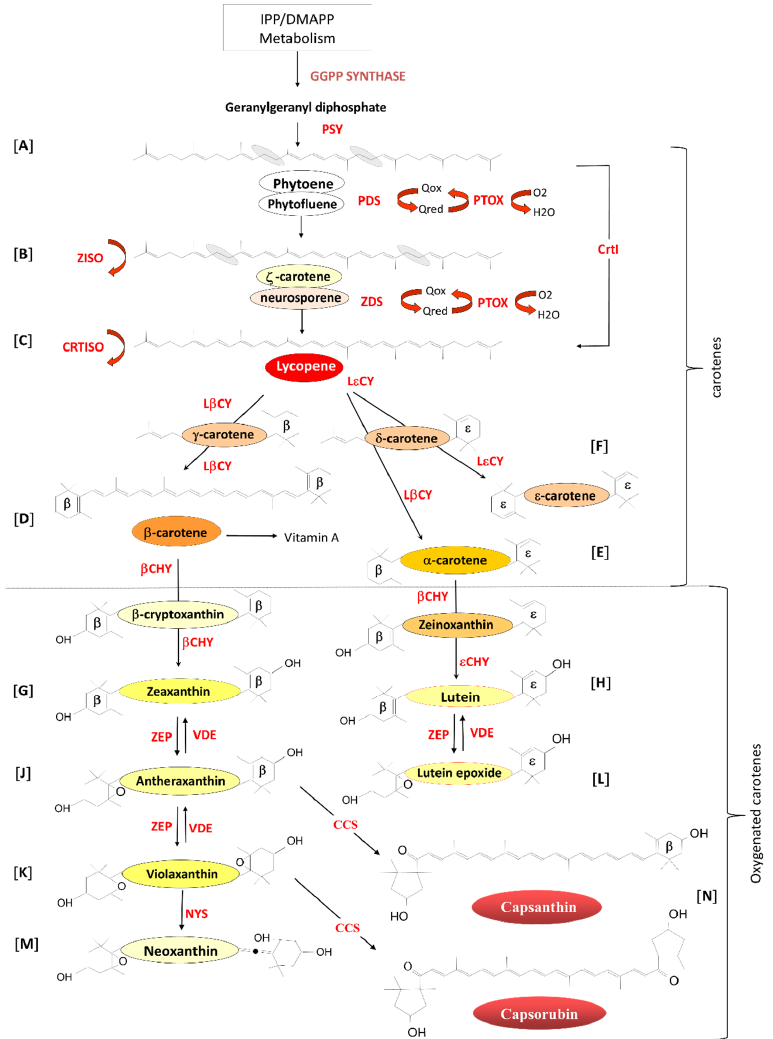
Figure 1. Overview of the biosynthesis of isoprenoids in plastids. PSY: Phytoene synthase. PDS: phytoene desaturase. ZDS: ζ -carotene desaturase. Z-ISO: ζ -carotene isomerase. PTOX: plastid terminal oxidase. CRTISO: carotene cis-trans isomerase. L β CY: lycopene β -cyclase. L ε CY: lycopene ε -